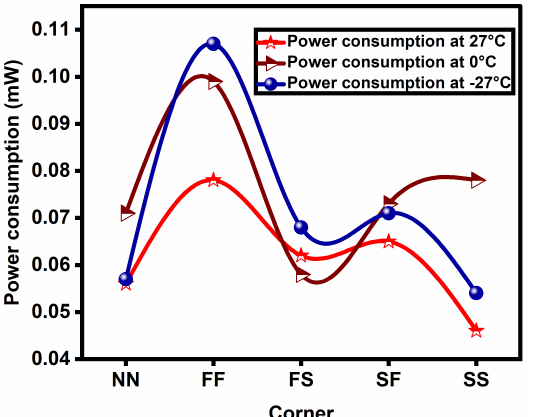
Figure 9. Power consumption comparison plot of proposed PLL among various corners at different temperatures.